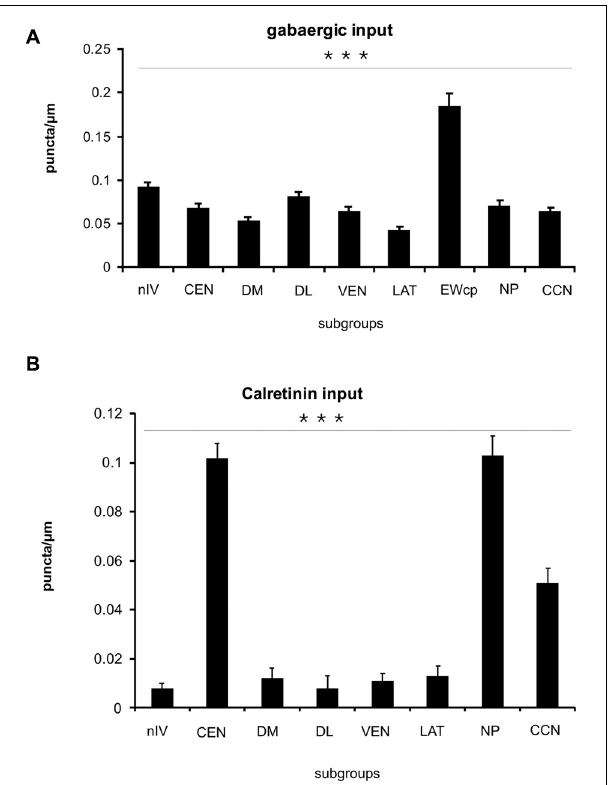
FIGURE 7 | Histogram of the quantitative analysis of GABAergic and calretinin (CR) input to motoneurons in the oculomotor and trochlear nucleus. The values are given in Table 3 . (A) The GABA-input was quantified by counting glutamate decarboxylase-positive (GAD) puncta along the measured length of the contour of a given neuron. The mean terminal density of input and the standard error of the mean values were calculated for each subgroup. The one-way analysis of variance revealed a significant difference ( p < 0.001). The strongest input is seen to non-preganglionic centrally projecting neurons in the Edinger–Westphal nucleus (EWcp; compare to Figure 4O ), whereas the neurons of all other subgroups did not show major differences. (B) The strongest CR input is seen to neurons of the nucleus of Perlia (NP), the central group in oculomotor nucleus (CEN), and the central caudal nucleus (CCN). The number of counted CR-positive puncta associated with putative